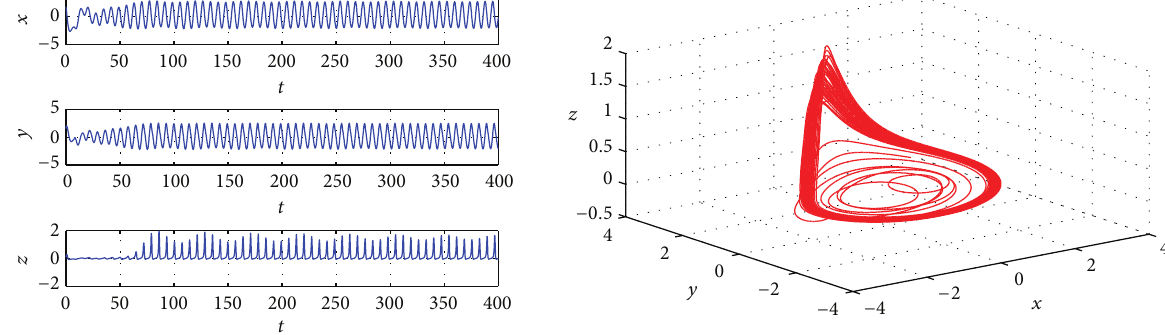
Figure 7: The trajectories and phase graphs of system (61) with 𝜏 = 7.3006 when 𝐾 = −1 .